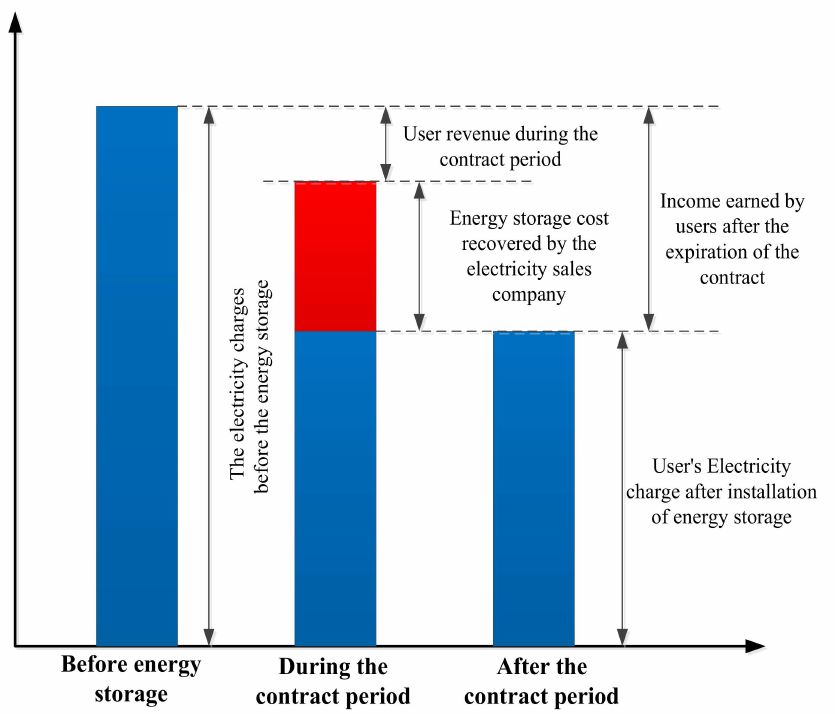
Figure 1. Schematic diagram of benefits before and after the installation of